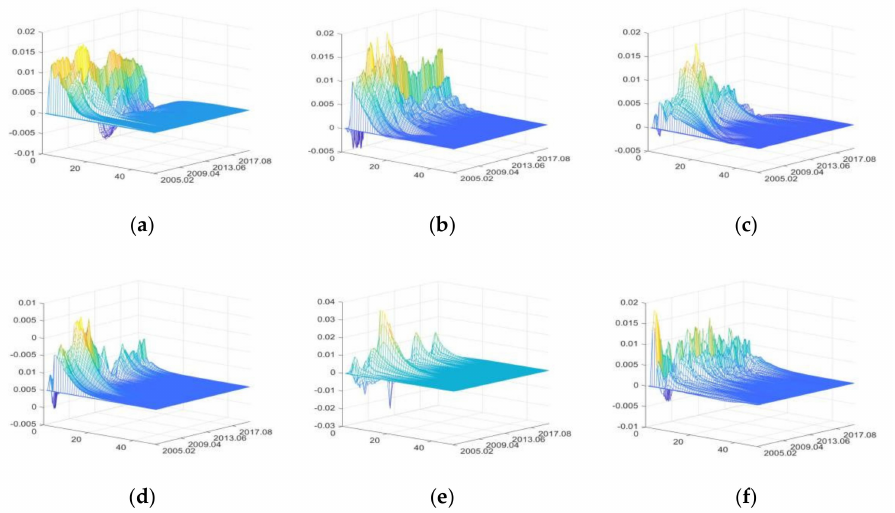
Figure 5. The three-dimensional impulse responses of PAPP to positive shocks of external uncer- tainties. ( a ) Shocks of IRU. ( b ) Shocks of FU. ( c ) Shocks of SDU. ( d ) Shocks of CU. ( e ) Shocks of DE. ( f ) Shocks of PHE. Note: The color is automatically generated by MATLAB software. The yellow color represents high value, blue color represents low value, and green color represents intermediate